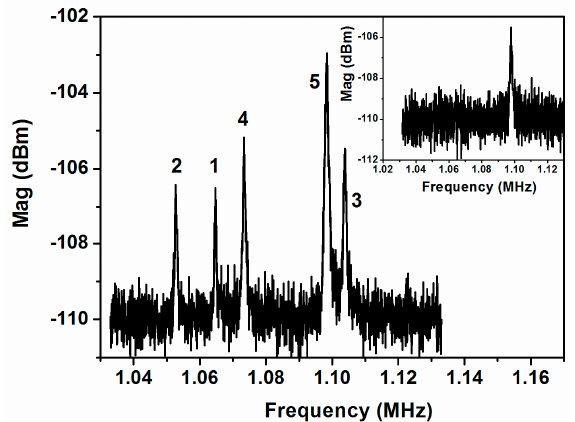
Figure 2. Thermomechanical noise measured at the common driver applying a DC voltage of 24 V at the system anchor. We flag the five peaks to identify each one with its corresponding cantilever (shown in Figure 1a). Peak number 5 is enhanced by the parasitic noise peak. Inset: parasitic noise peak measured at 0 V of DC voltage.